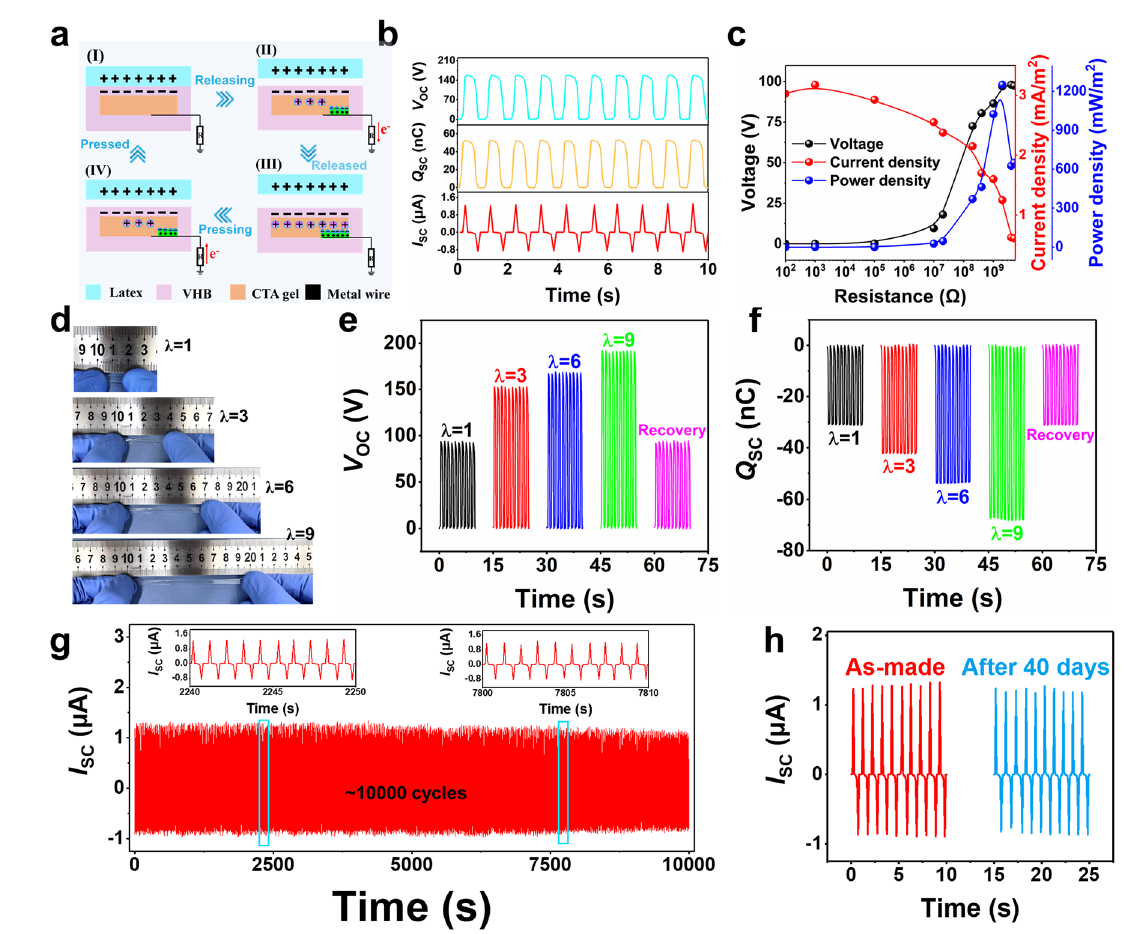
Fig. 7 a Schematic exhibiting the working principle of CTA-TENG. b The corresponding V OC , I SC , and Q SC of CTA-TENG. c Variation of the electrical output performances of CTA-TENG as a function of external resistors. d Photographs of a CTA-TENG in initial state and different stretched states. e V OC of a CTA-TENG in initial state and different stretched states. f Q SC of a CTA-TENG in initial state and different stretched states. g Long-term stability test of CTA-TENG. h I SC of CTA-TENG after storage for 40